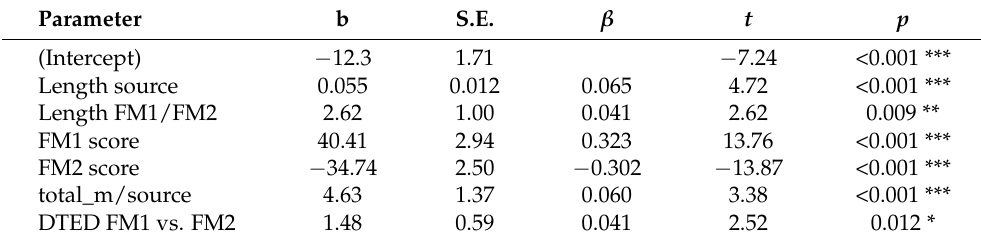
Table 14. Parameter estimates (b), standard errors (S.E.), standardised estimates ( β ), t - and p -values for the linear model estimating TER difference. Adjusted R 2 = 0.064. (* p < 0.05; ** p < 0.01; *** p < 0.001).